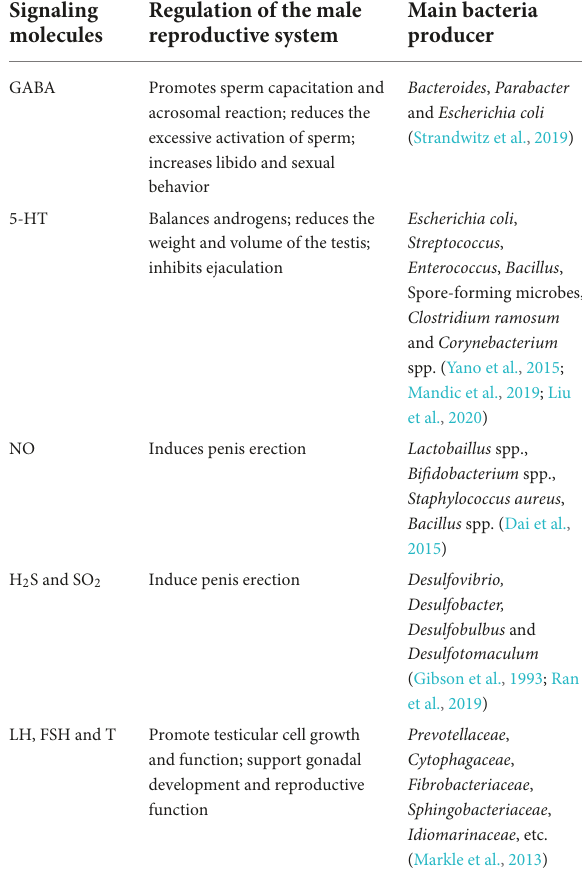
TABLE 2 The summary of GM secreted signaling molecules regulating the male reproductive system. Signaling